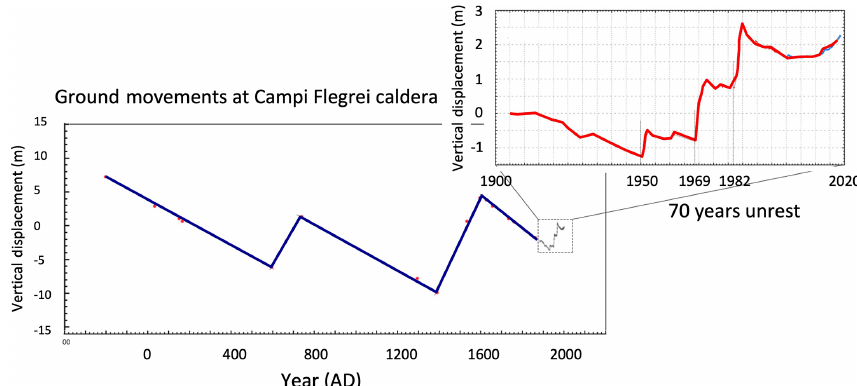
Figure 7. Ground movements at the Campi Flegrei caldera centre (Port of Pozzuoli). The larger figure shows secular displacements, inferred from the traces of marine ingression on the archaeological remains of Serapeo (redrawn after Bellucci et al., 2006b, and Troise et al., 2019). The enlarged figure shows the vertical displacements observed between 1900 and the present; data here are from precision levellings until 2000 and then from continuous GPS